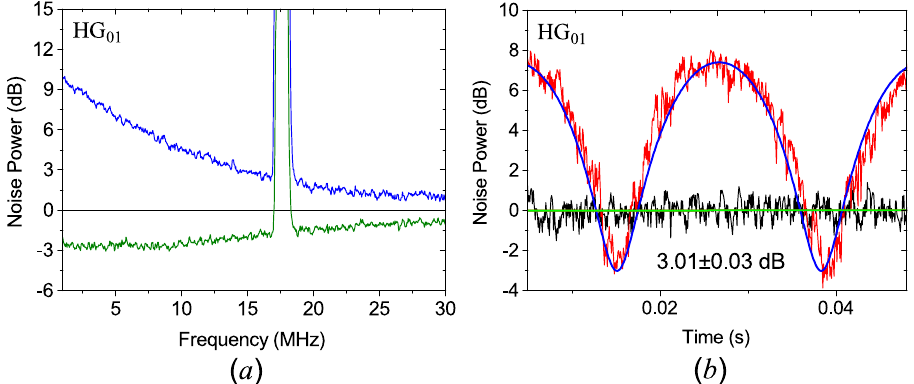
Figure 5. Noise power for the HG 01 mode. ( a ) the squeezing and anti-squeezing values for HG 01 mode from 1 MHz to 30 MHz. ( b ) the noise power for HG 01 mode at 5 MHz.